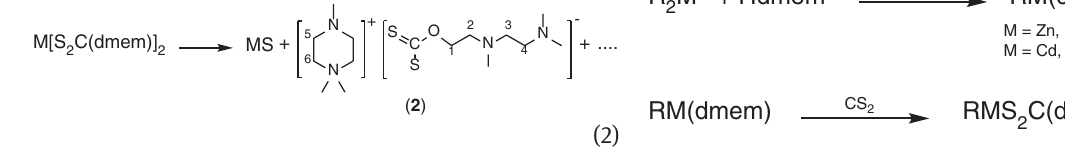
Scheme 2: Synthetic routes to compounds 3 and 4 and attempted Zn and Cd xanthate synthesis.